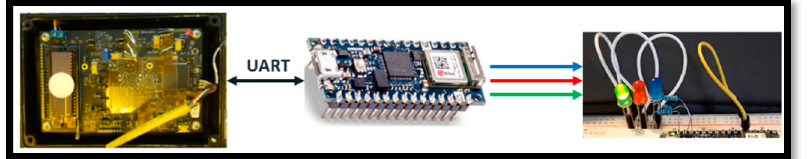
Figure 2. A schematic depiction of the full system: An Arduino controller requests samples from GMOS over UART and lights a LED bulb according to its gas classification.